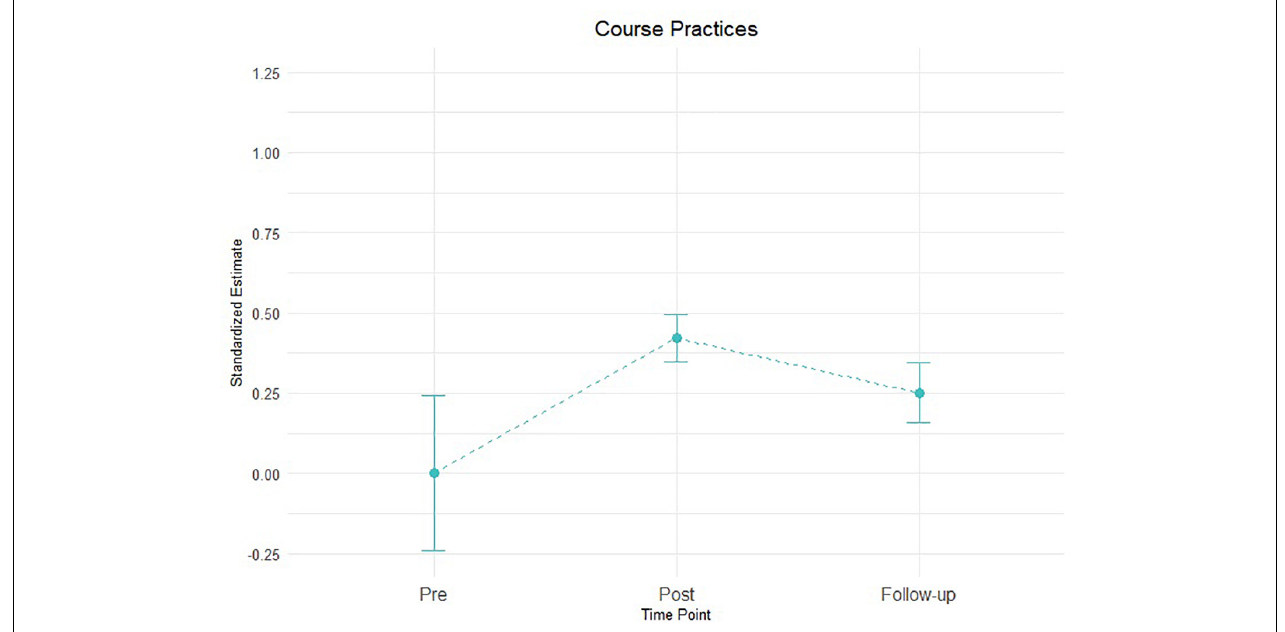
FIGURE 2 | Estimated change in practices from pre-survey